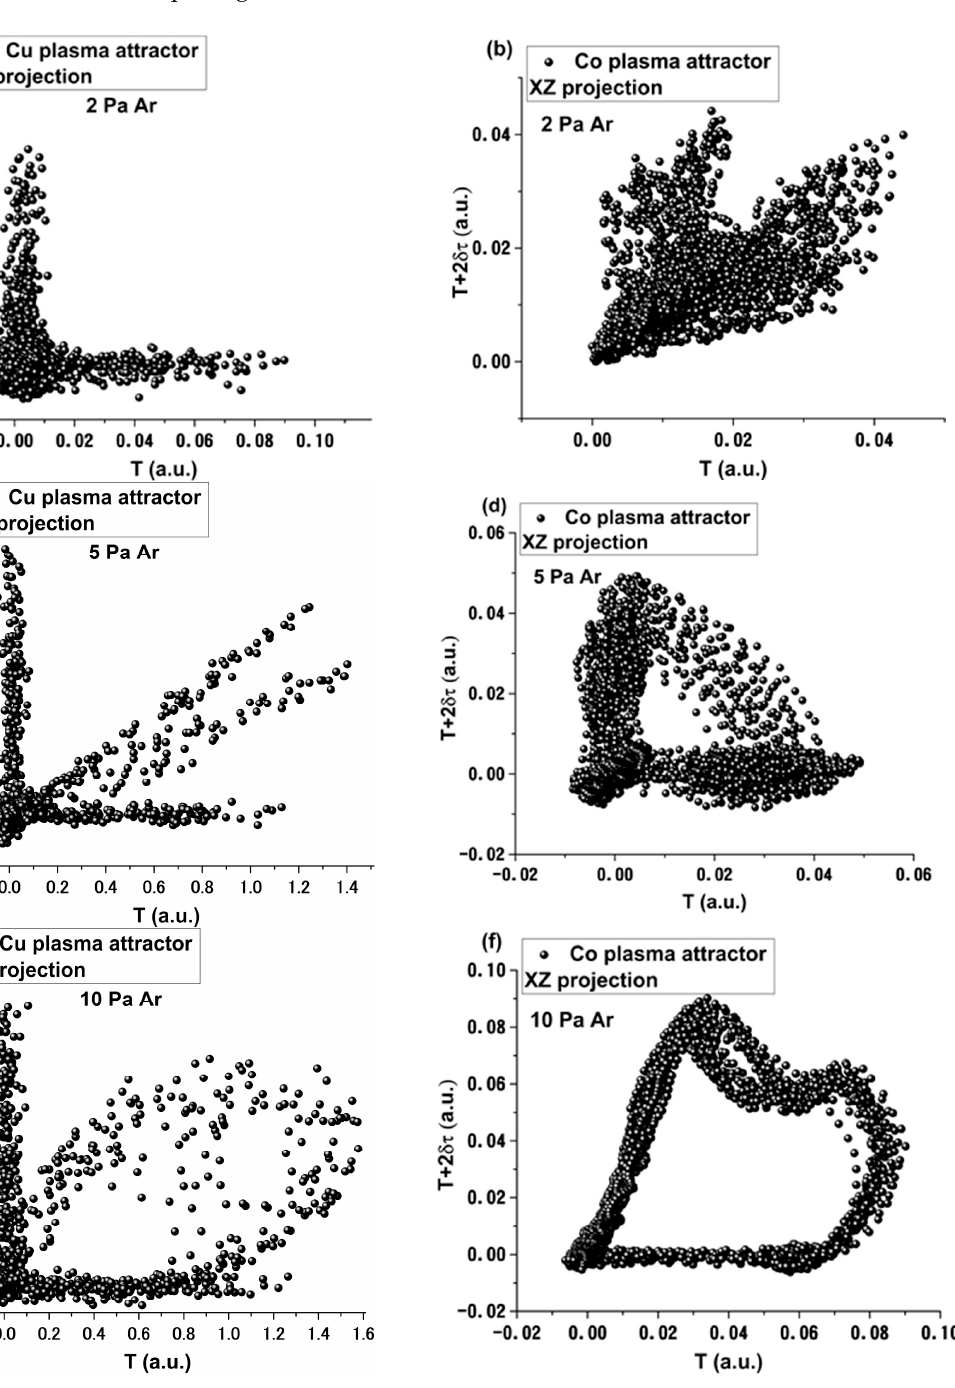
Figure 4. The 2D representation of the attractor associated to the oscillatory behavior observed for Cu at 2 Pa ( a ), 5 Pa ( c ) and 10 Pa ( e ) and Co at 2 Pa ( b ), 5 Pa ( d ) and 10 Pa ( f ).